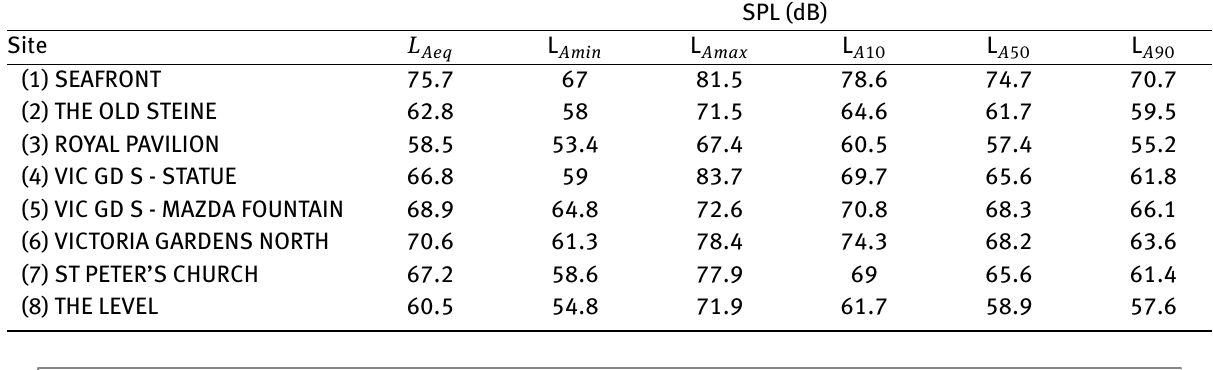
Table 1: Statistical noise levels for the eight selected locations (average of left and right channel)